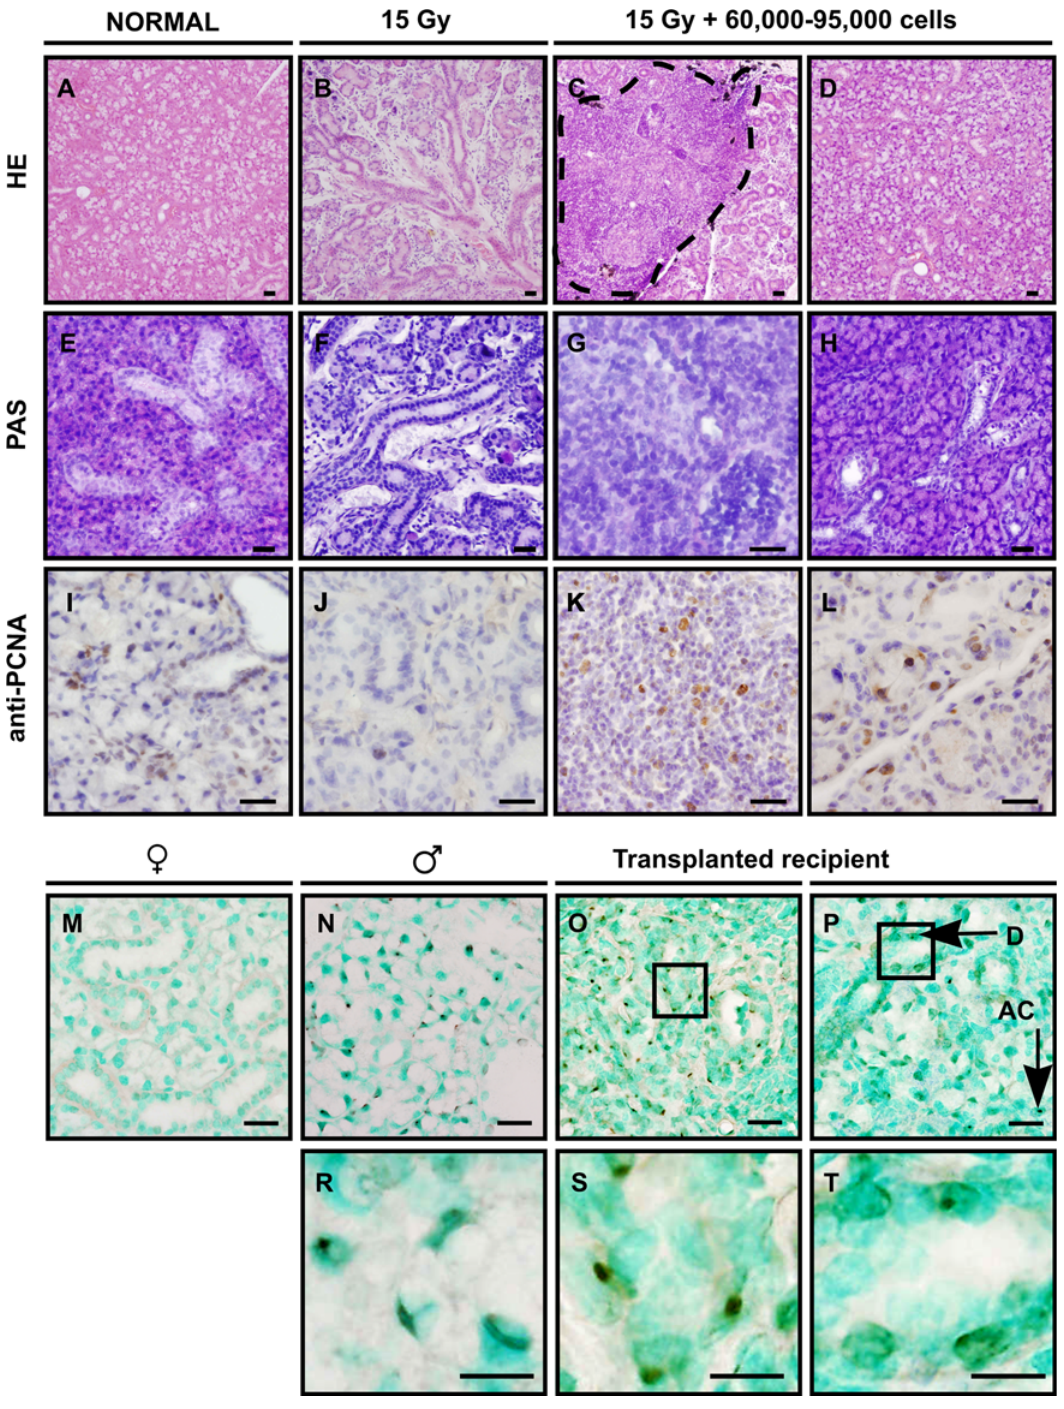
Figure 5. Restored morphology after injection of cultured stem cells. Single cells from day 3 salispheres were intra-glandularly injected 30 days post-irradiation and glands were analyzed 90 days post-irradiation. From left to right, normal unirradiated glands (A,E,I), irradiated non- transplanted glands (B,F,J), irradiated transplanted glands (C,G,K) at the site of injection and irradiated transplanted glands away from the injection site (D,H,L). Irradiated glands hardly contained acinar cells (B,F) as visualized by HE or PAS. In contrast, in transplanted glands, ductal cells at the site of injection (dashed line) (C,G), and acinar cells further in the tissue were readily detectable (D,H). In normal (I) and irradiated glands (J) hardly any cells stained for PCNA. In contrast, PCNA labeled proliferating cells were present at and outside the site of injection (K,L). In situ hybridization to detect Y chromosomes of male transplanted cells in female recipient mice. (M) No staining in female control tissue and specific staining in male control mice (N, enlargement in R). Cells at the site of injection (O, enlargement in S), as well as distant ductal cells (P, enlargement in T) and acinar cells were donor derived. Nuclei are visualized in blue or green. Scale bar=50 m m, enlarged pictures (R,S,T)=20 m m.